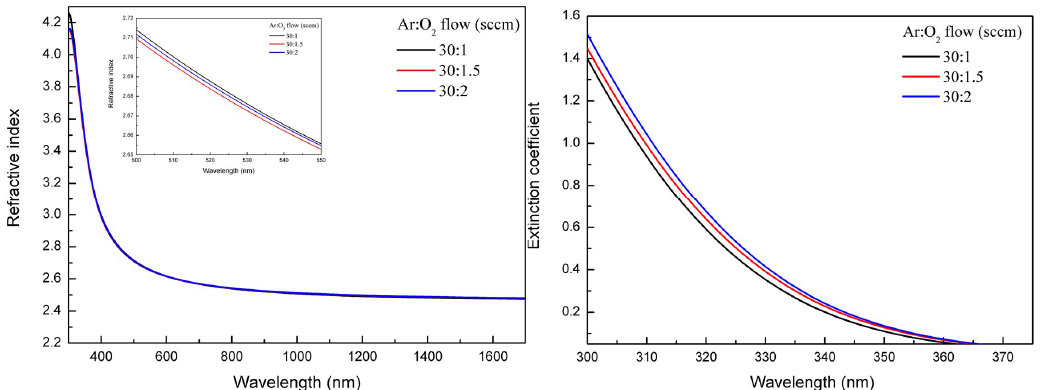
Figure 7. The dispersion of optical constants: ( a ) Refractive index (inset: enhancement in the wavelength range of 500–550 nm) and ( b ) extinction coefficient for the as-deposited TiO 2 thin films obtained from fitting with a single Gauss oscillator.